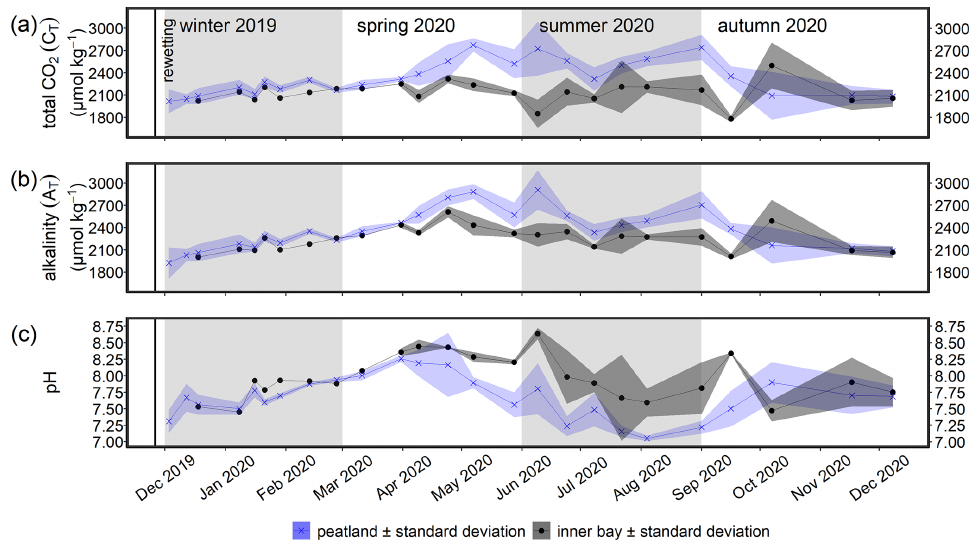
Figure 6. Time series of the mean (a) total CO 2 ( C T ), (b) total alkalinity ( A T ), and (c) pH ( ± standard deviation) in the surface water after rewetting, as measured from December 2019 to December 2020. Data from the flooded peatland ( n = 6) are shown in blue and data from the inner bay (until 11 March 2020, n = 1; thereafter, n = 2) in black. The vertical black line indicates the rewetting event.